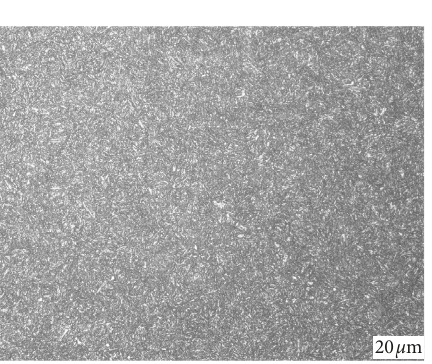
Figure 4: Metallographic structure of bolt